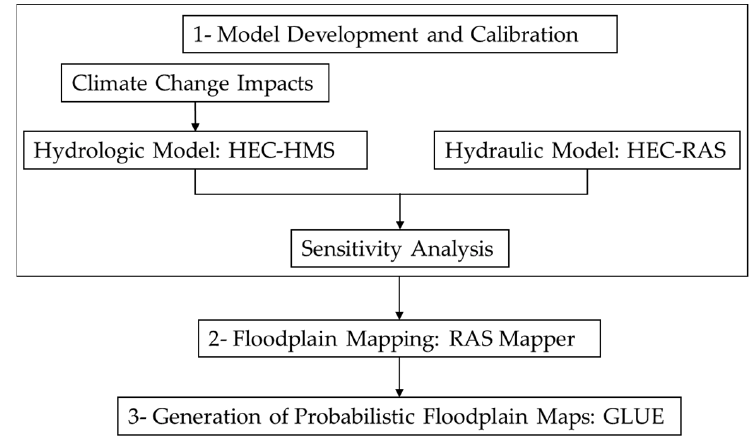
Figure 2. Flowchart for integrated flood modeling and floodplain mapping.